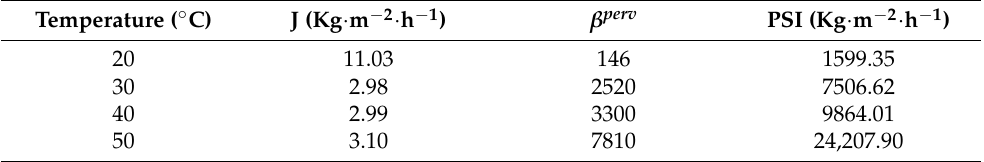
Table 11. Pervaporative parameters of a SILICONE1200 membrane obtained during 1.5 h of separa- tion at different temperatures with a stirring rate of 250 rpm and a membrane thickness of 260 µ